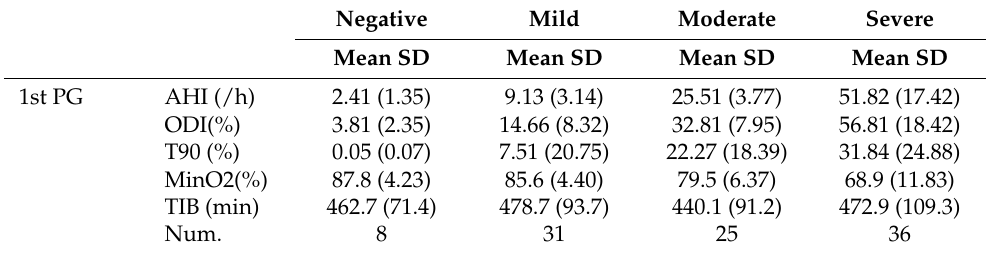
Table 1. Severity-dependent characteristic values of the AHI, ODI, T90, MinO2, TIB, and Num. of the two consecutive polygraphic